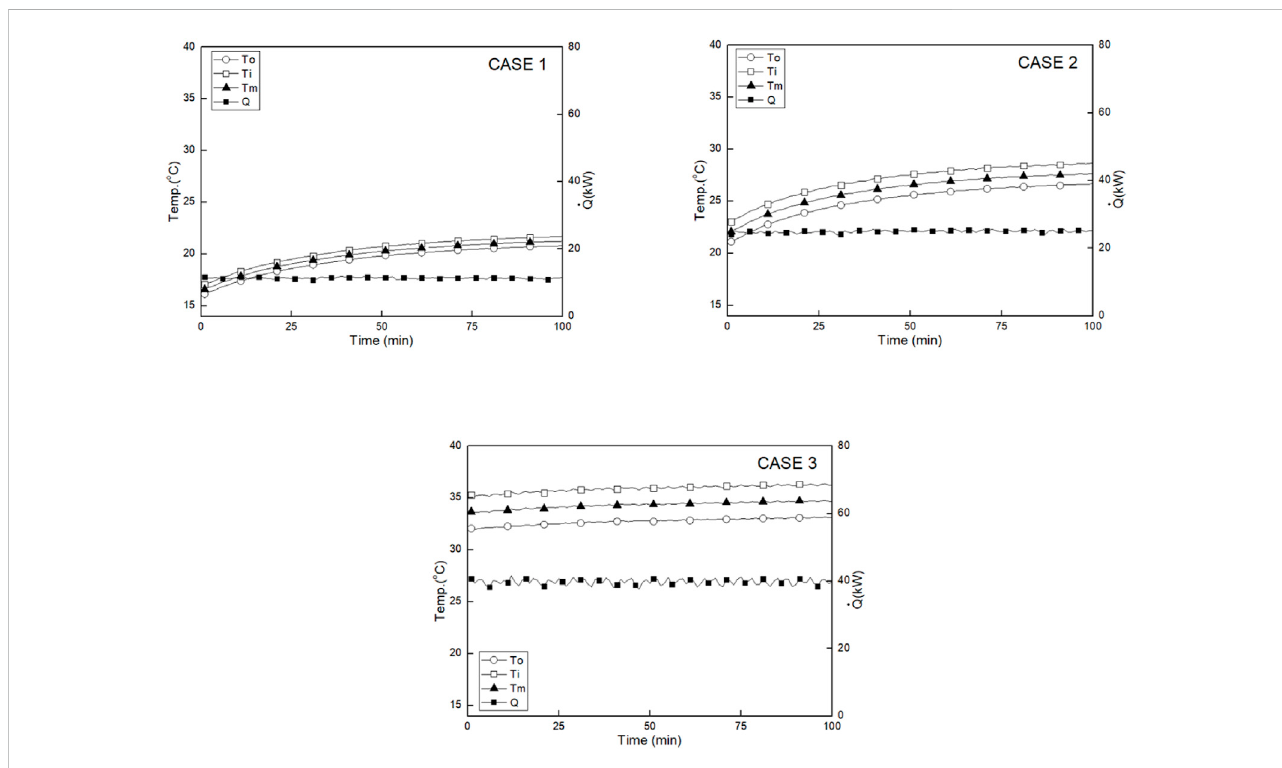
FIGURE 3 Variation of the T i , T o , Tm and power consumption (HDPE H/X).